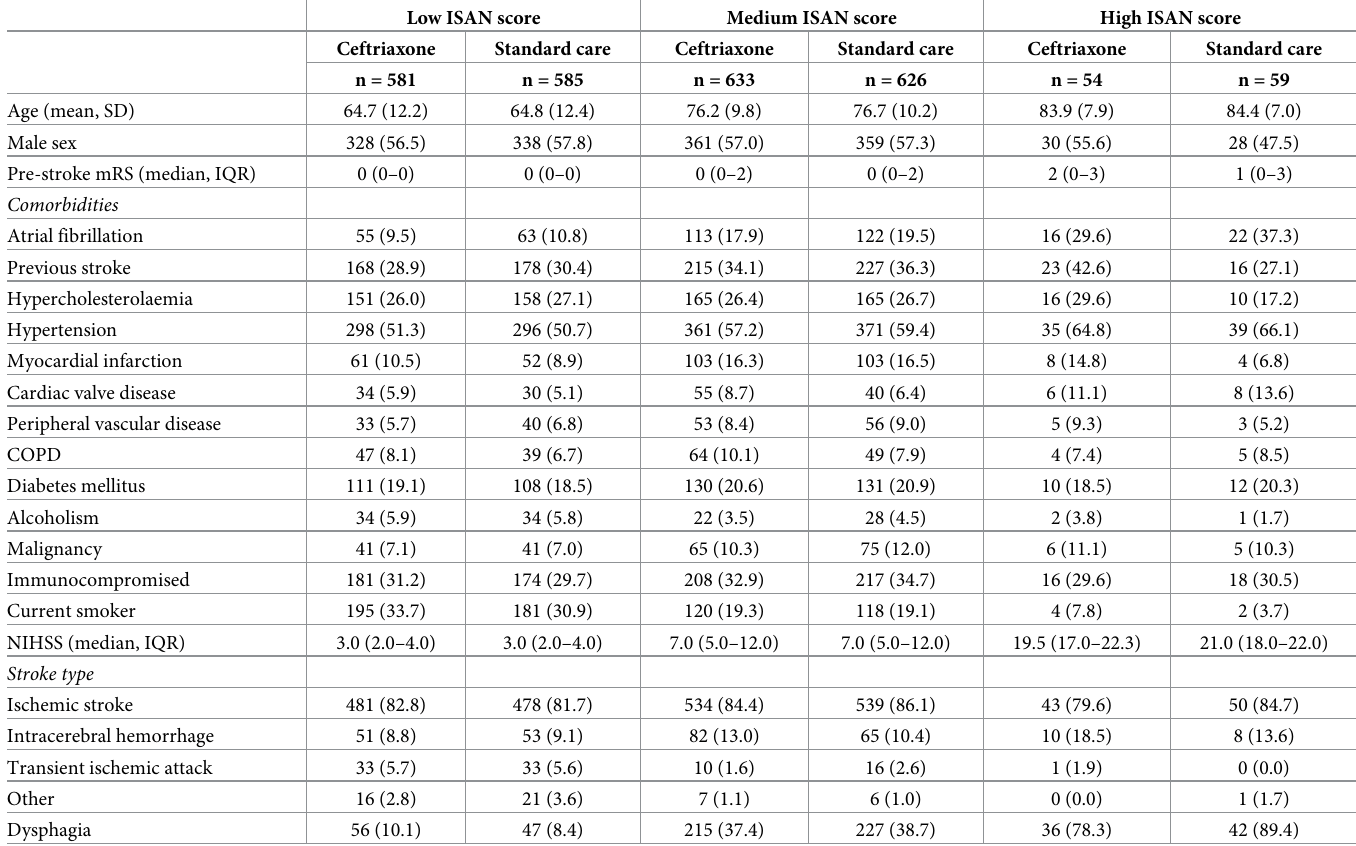
Table 2. Baseline characteristics of patients with a low, medium or high ISAN score stratified by treatment group. Low ISAN score Medium ISAN score High ISAN